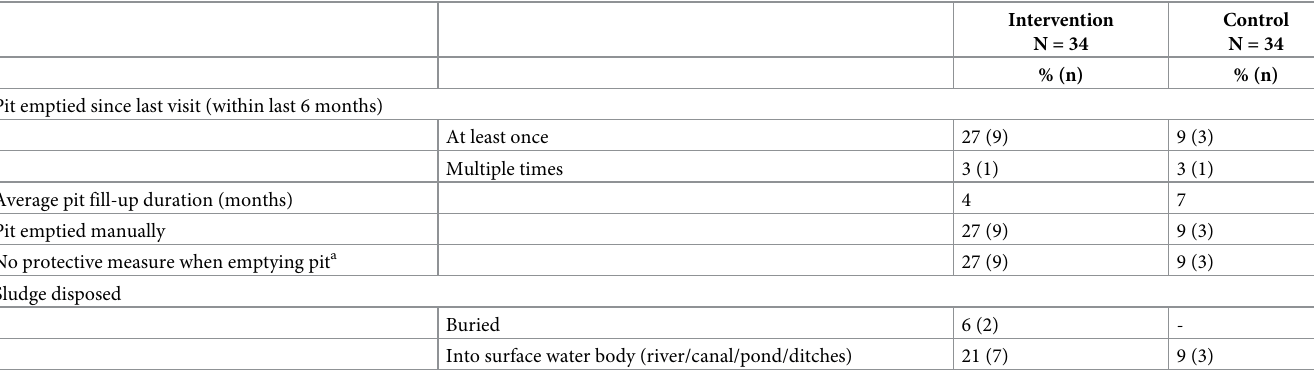
Table 4. Pit emptying practices of the intervention and control latrine